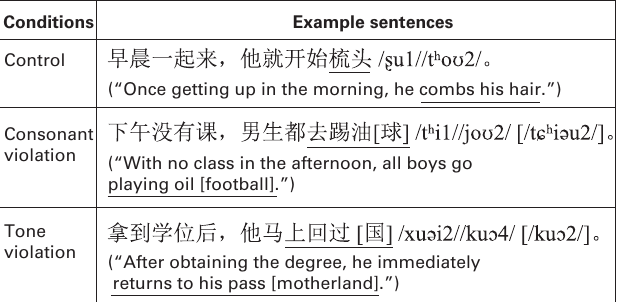
Table 3 | Example sentences and experimental conditions in Experiment